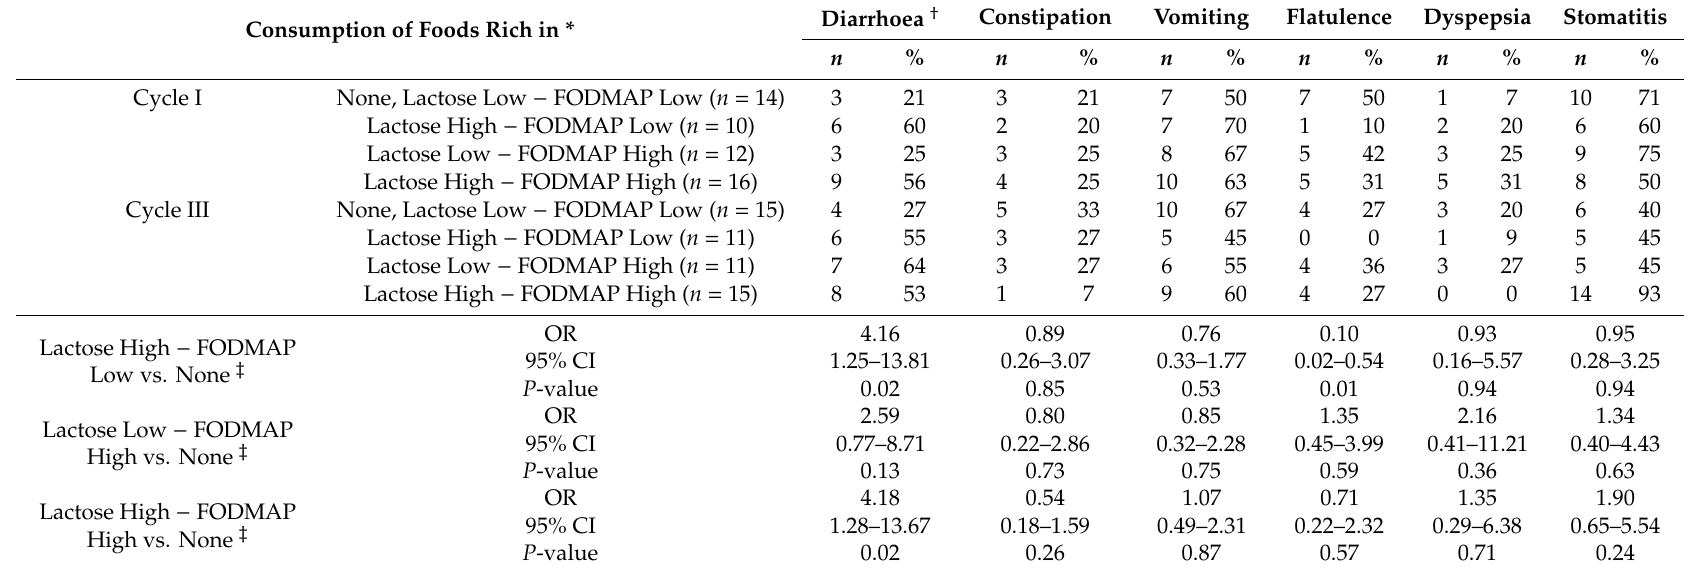
Table 3. Prevalence of chemo(radio)therapy-related gastrointestinal symptoms of at least mild intensity (Grade 1–4) during cycles I and III according to the combinations of lactose-rich and FODMAP-rich foods in 52 colorectal cancer patients (univariate